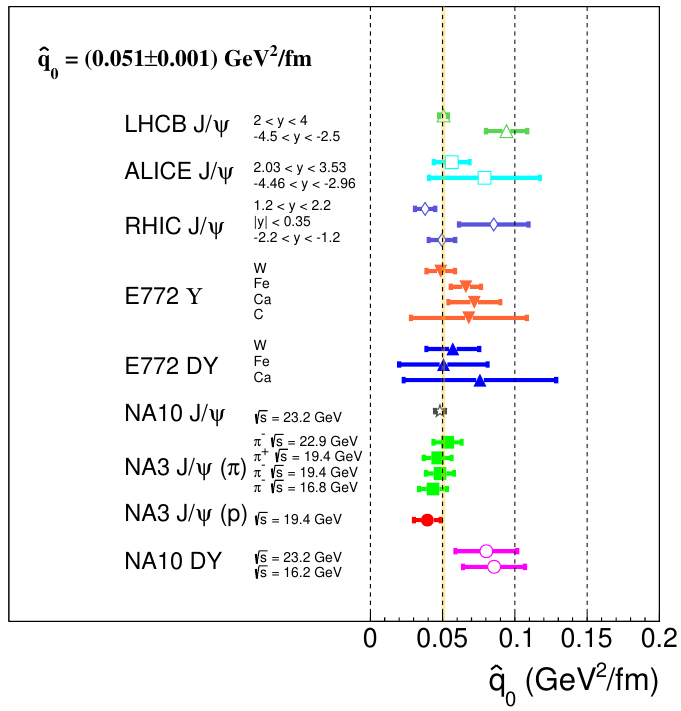
Figure 4 . Extracted values of ^ q 0 from each measurement of (cid:1) p 2 p descending order of s energy, data points in ascending order of atomic number (E772) and rapidity (PHENIX, ALICE,